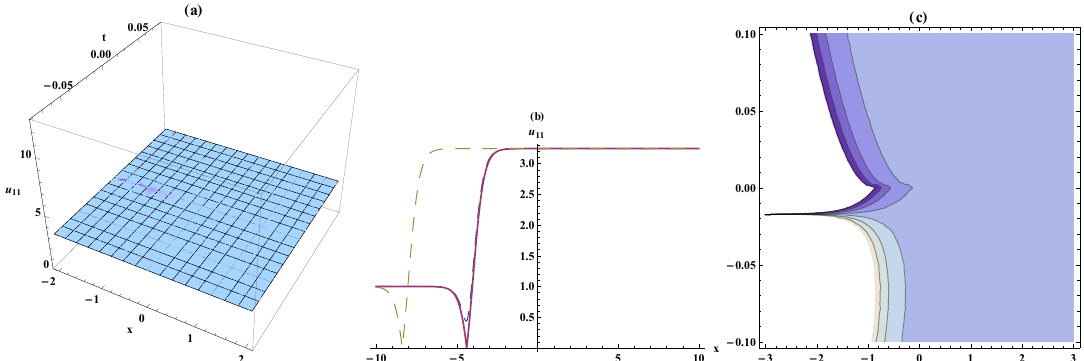
Figure 5. Solitary wave, the bistable wave amplitude, and contour plots for Equation (25). On the respective interval { x , − 2.05,2.05 } , { t , − 0.08,0.08 } , { x , − 10,10 } , { t , − 1,1 } , { x , − 3,3 } , { t , − 0.1,0.1 } .